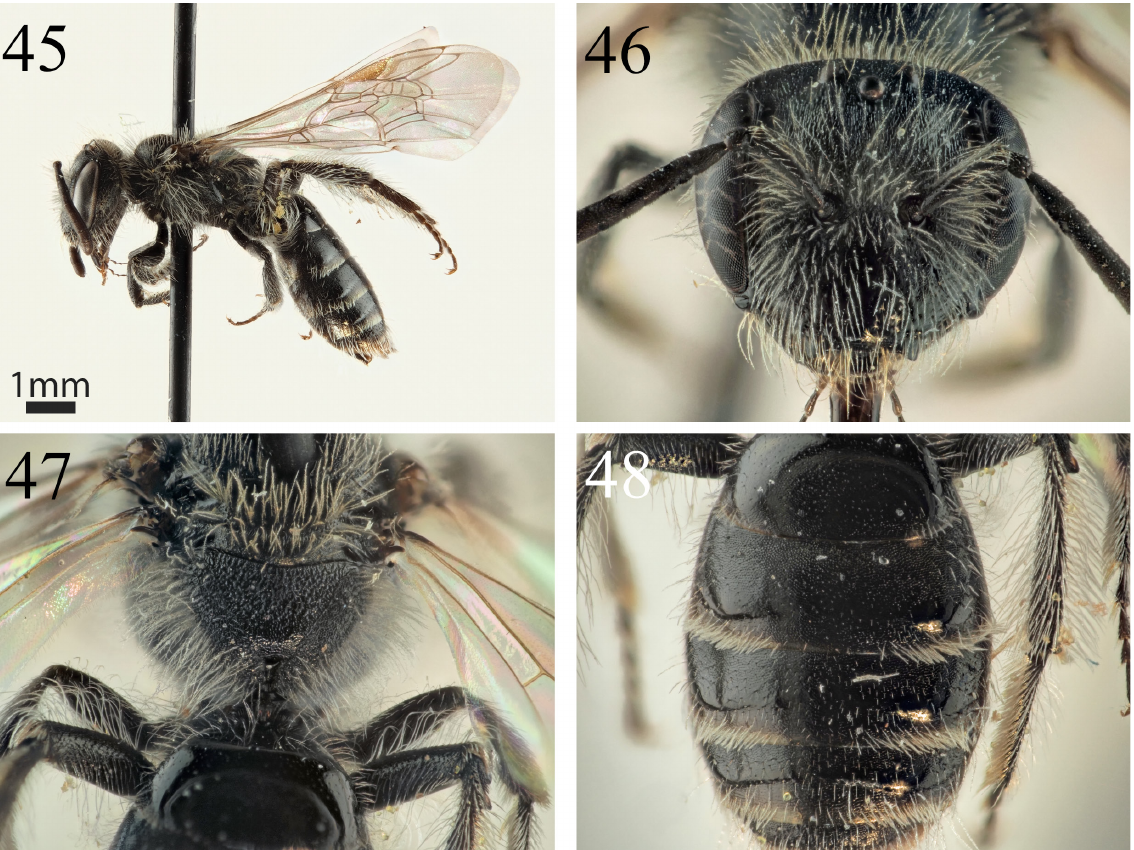
Figs 45–48. Andrena extenuata sp. nov., ♀ (OÖLM). 45 . Profile. 46 . Face. 47 . Propodeum. 48 .